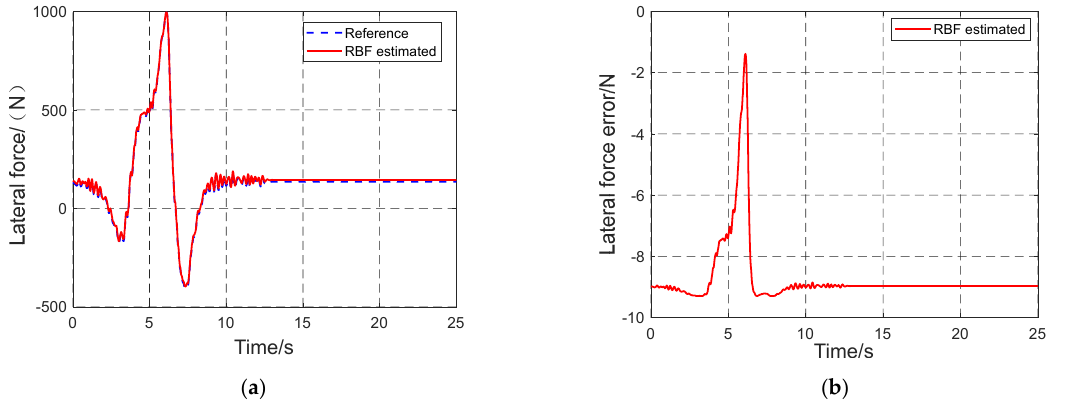
Figure 10. Estimation results based on RBF neural network tire lateral force under ice-covered pavement; ( a ) The lateral force; ( b ) Discrepancy between the estimated lateral force and the true value.